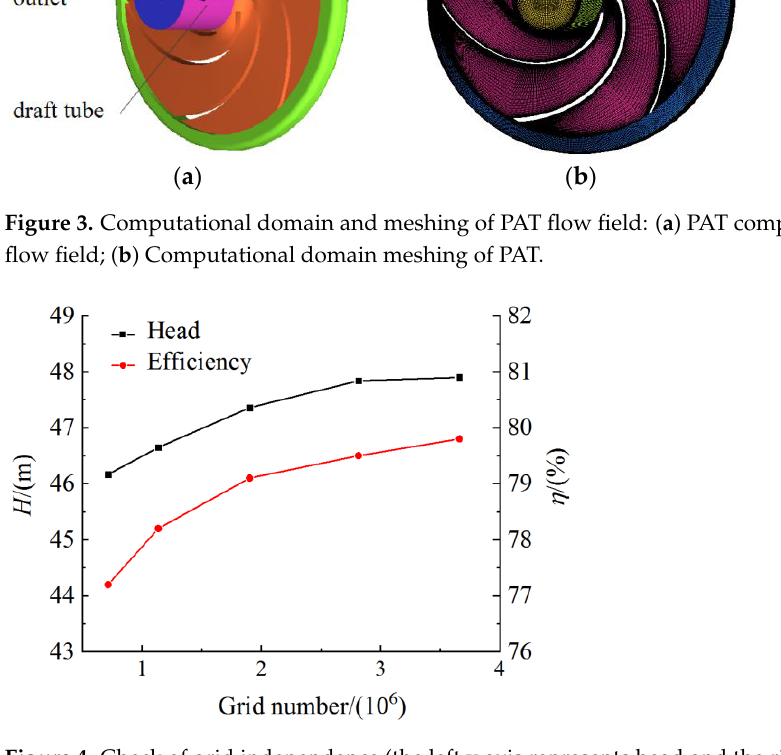
Figure 4. Check of grid independence (the left y axis represents head and the right y axis represents efficiency).